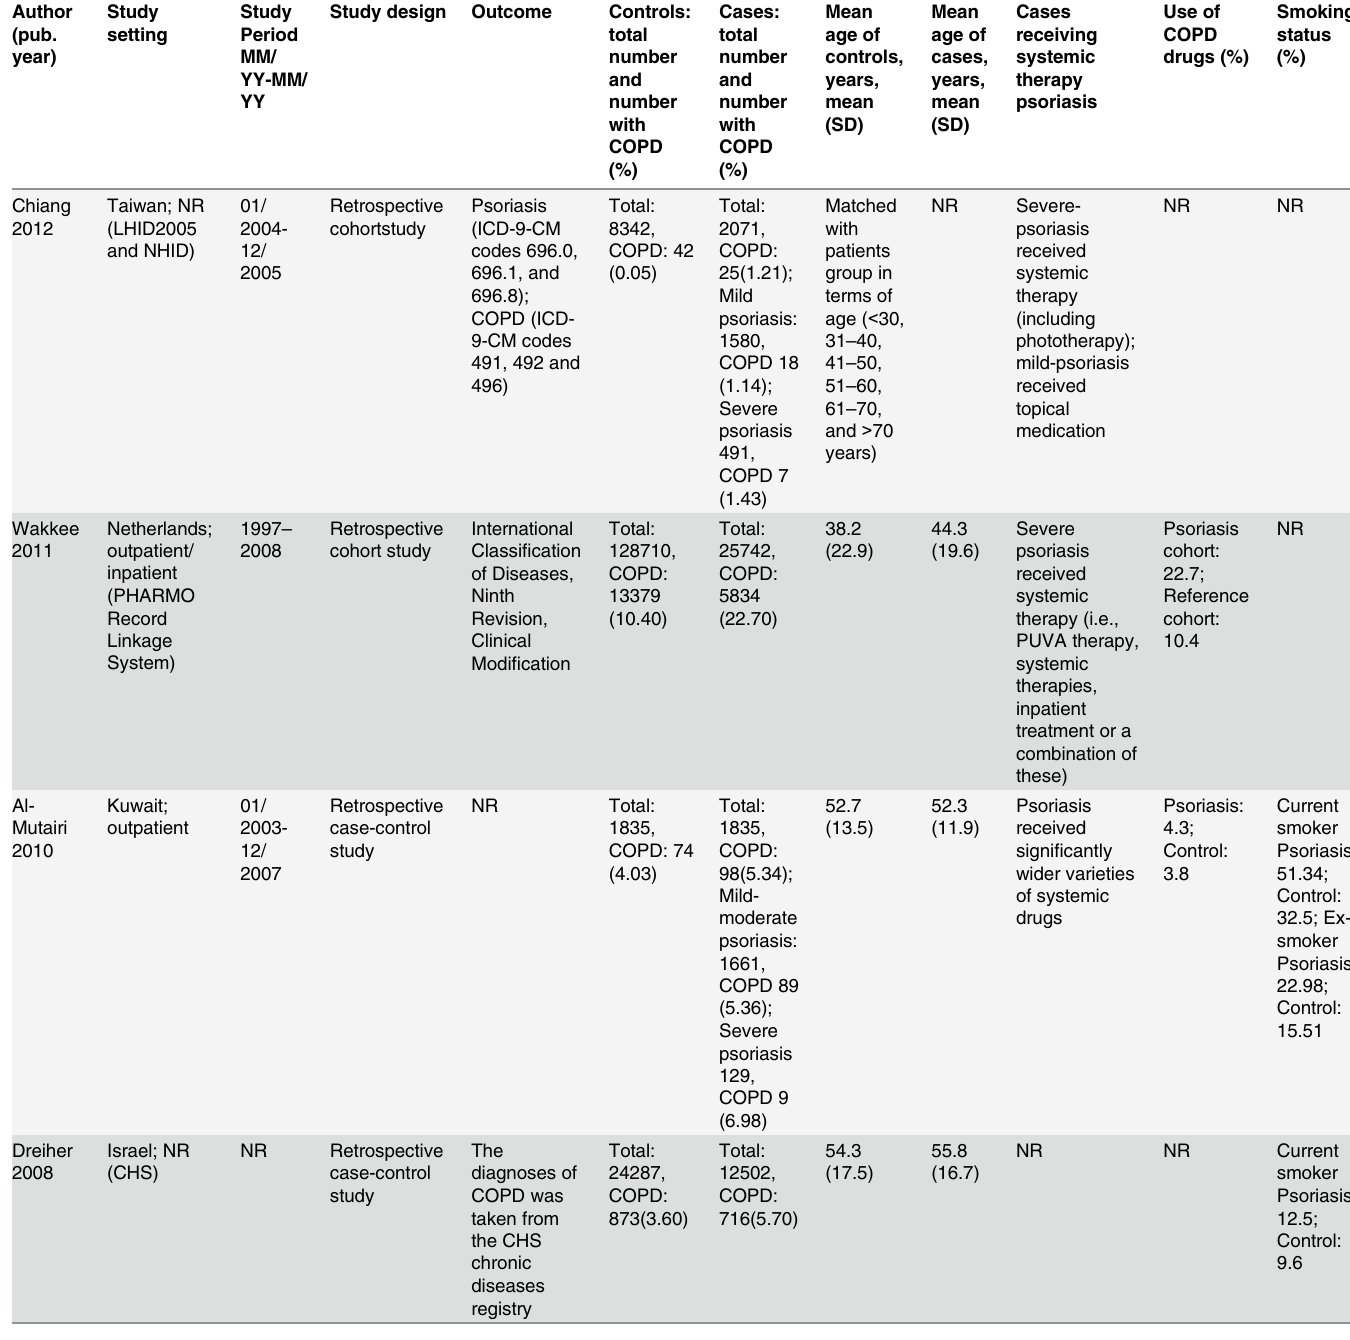
Table 1. Included Observational